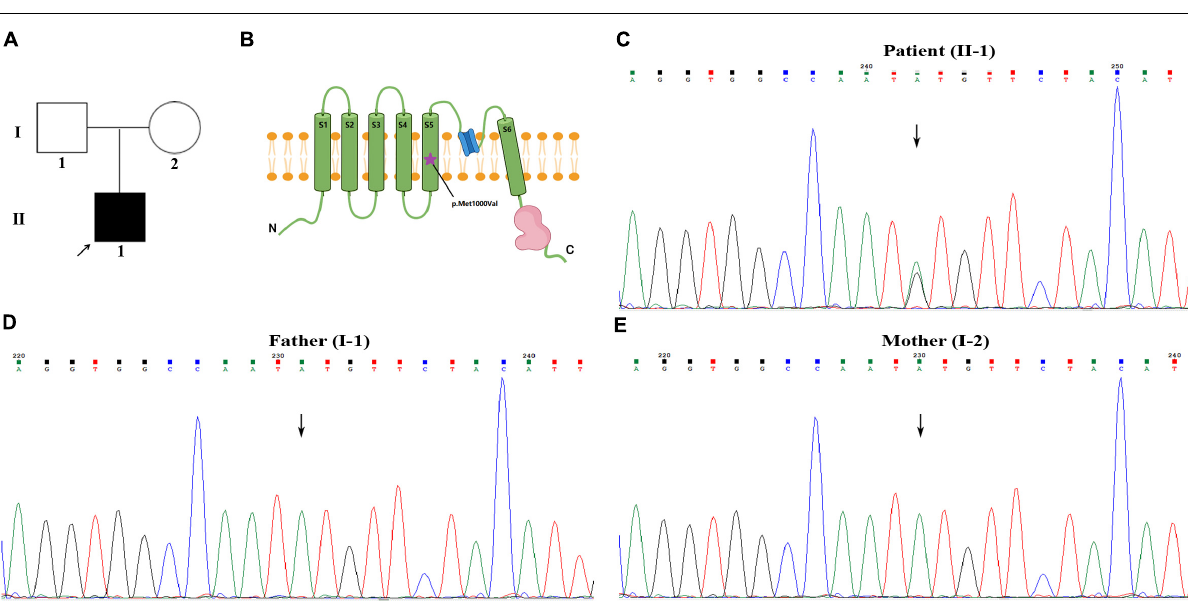
FIGURE 2 | Identification of a de novo heterozygous variant of c.2998A > G in TRPM7 gene. (A) Pedigree chart in this family. (B) The schematic diagram of TRPM7 protein molecular structure, the purple star indicates the variant is located in the fifth transmembrane segment. (C–E) Patient with c.2998A > G variant, his parents with normal